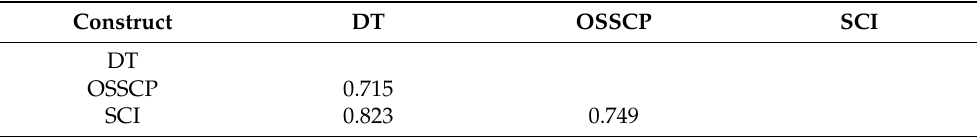
Table 4. Heterotrait–monotrait (HTMT) discriminant validity of the main study.